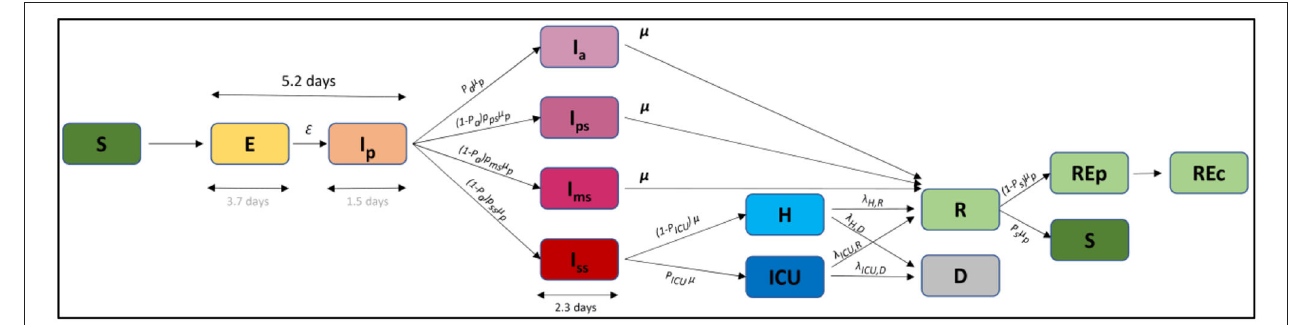
FIGURE 1 | Compartmental model. S, susceptible; E, exposed; Ip, infectious in the prodromic phase; Ia, asymptomatic infectious; Ips, paucisymptomatic infectious; Ims, symptomatic infectious with mild symptoms; Iss, symptomatic infectious with severe symptoms; ICU, severe case admitted to ICU; H, severe case admitted to the hospital but not in intensive care; Rep, recovered without economic activity; Rep, recovered with economic activity; D, deceased.